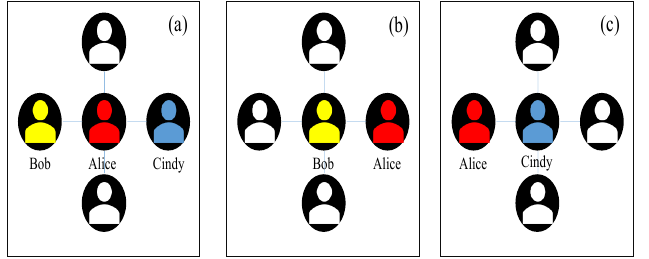
Figure 1. Locally-mixed groups in social networks. As shown in the subfigure ( a ), Alice (the red one) forms a locally-mixed group with her four neighbors. Meanwhile, she is also a member of locally- mixed groups of her neighbors Bob and Cindy, as shown in the right two figures, i.e., subfigures ( b , c ). Therefore, Alice’s vaccination strategy can also affect other members in the groups of Bob and Cindy. We define this effect as the influence of individuals on their “neighbors of